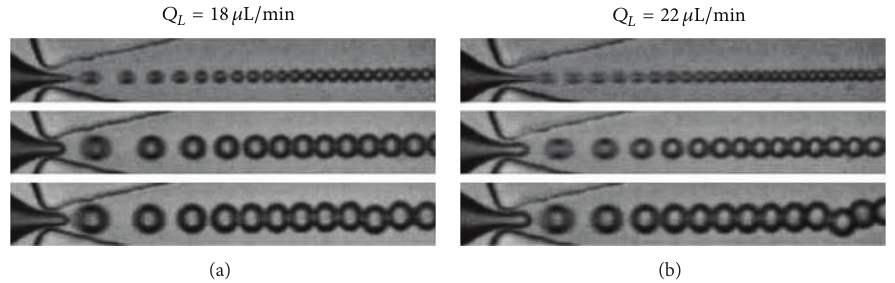
Figure 1: Sequence of images showing the effect of increasing (top-to-bottom) liquid dodecafluoropentane pump pressure for two phospholipid flows in the dripping regime. The droplet diameter decreases and the generation frequency quickens as Q image height is 25 𝜇 m. Reproduced from [68] with permission from the Royal Society of